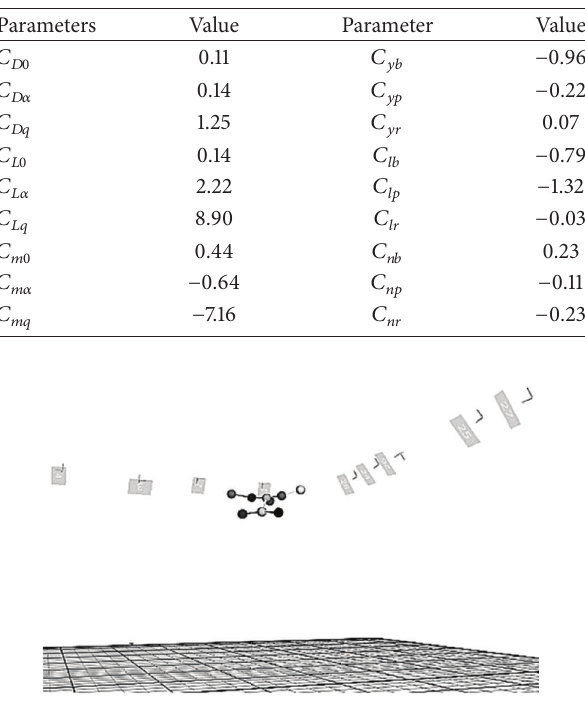
Table 2: Estimated MAV aerodynamic and thrust coefficients.